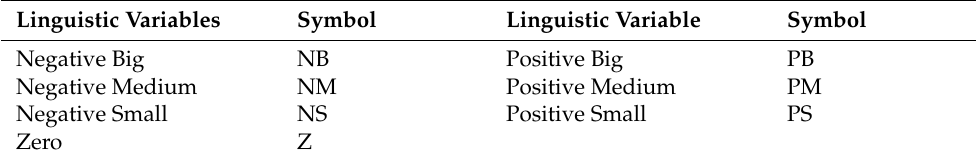
Table 2. Linguistic variables for